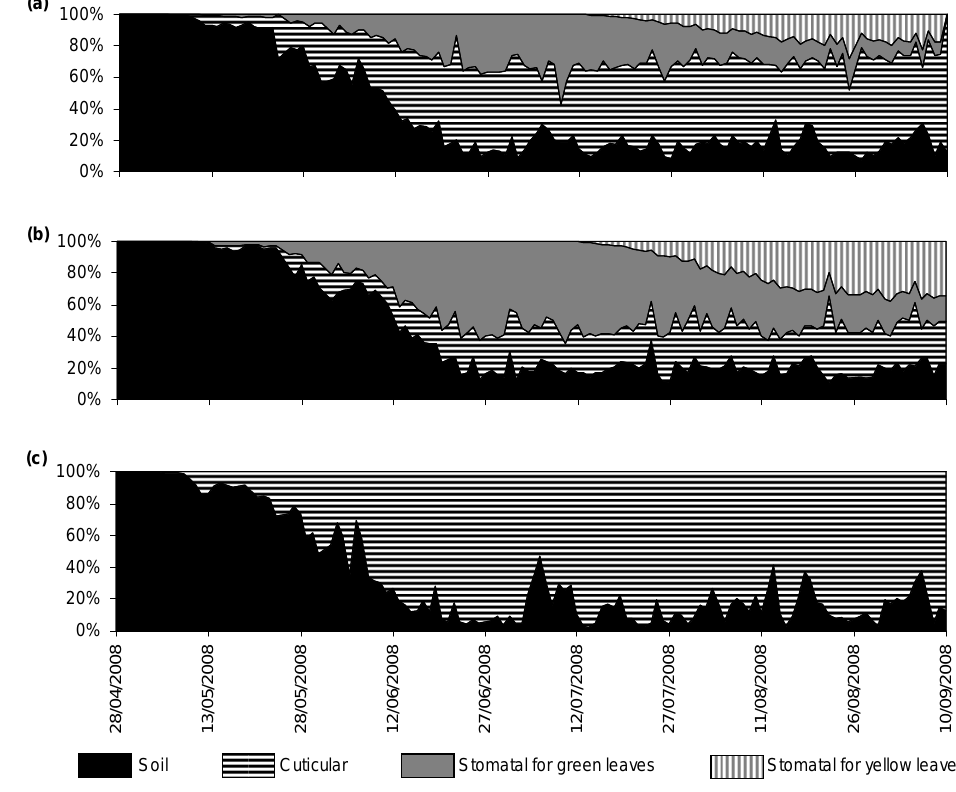
Fig. 8. Mean (a) daily, (b) diurnal and (c) nocturnal relative contributions of soil, cuticular, stomatal for green leaves, and stomatal for yellow leaves pathways to total ozone flux over the whole study period for the Grignon site.